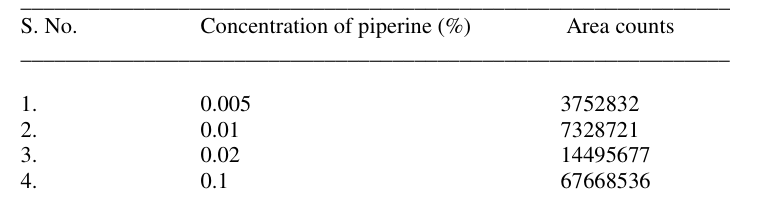
Table 2 . Area counts for standard